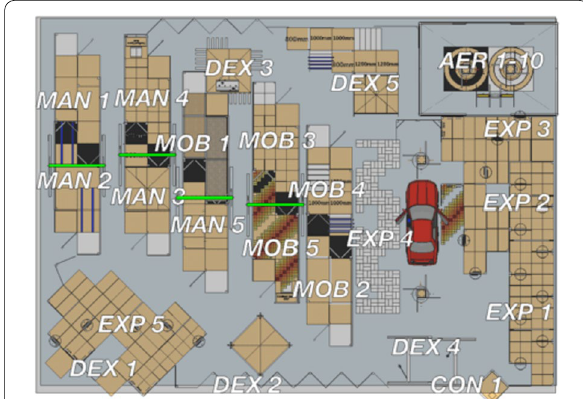
Fig. 3 Arena layout sample for Maneuvering (MAN), Mobility (MOB), Dexterity (DEX), and Exploration (EXP) test suites in RRL (figure obtained from RRL’s rulebook 2019